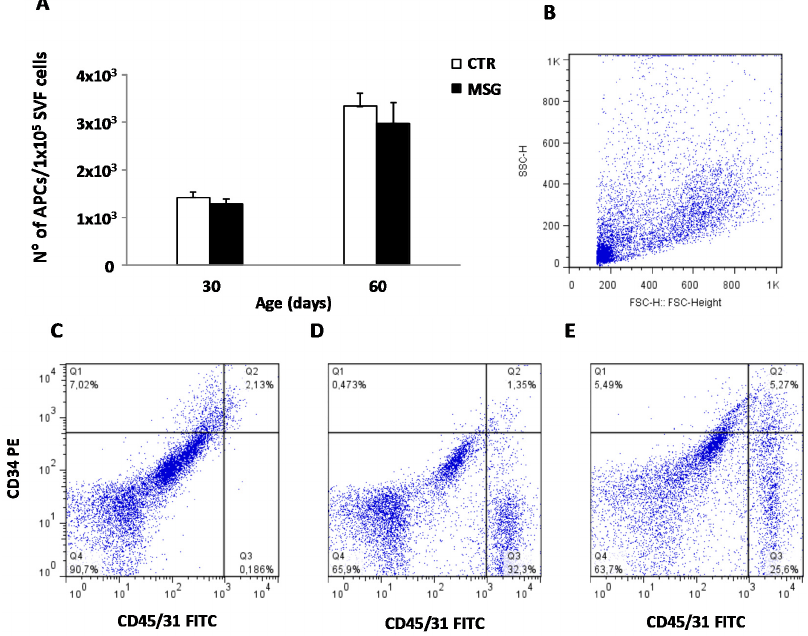
Figure 5. High GC exposure does not change adipocyte precursor cells (APCs) number. ( A ) Number of APCs in SVF from CTR and MSG animals at both ages. Adipocyte progenitors were identified by flow cytometry analysis using the CD34 + /CD31 − /CD45 − profile; ( B ) Characteristic forward versus side scatter dot plot of freshly-isolated SVF cells from RPAT. Fluorescence profiles obtained for ( C ) IgG isotype control FITC conjugated combined with CD34 PE staining; ( D ) IgG1 isotype control PE conjugated combined with CD45/CD31 FITC staining and ( E ) APC subset (upper left quadrant). FITC: fluorescein isothiocyanate; PE: phycoerythrin. Values are means ± SEM ( n = 3/4 different experiments).